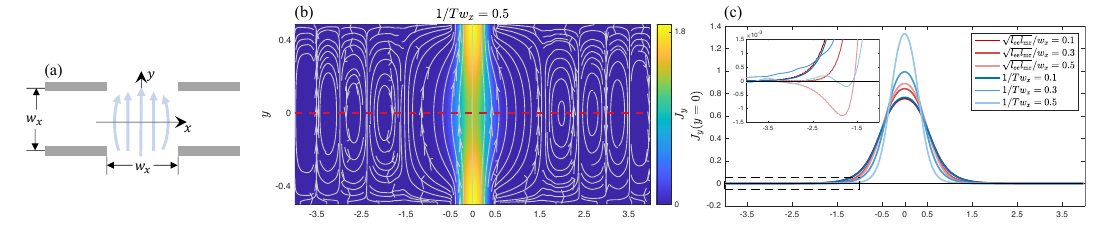
Figure 13: Vortices in a strip geometry. (a): the constriction (gray area) is located / 2 and | x | ≥ w / 2 with w = 1 µ m and w (cid:28) w at y = ± w . The current en- x x x y x / 2 and exists through a slit at y = w / 2. (b): 2D ters through a slit at y = − w x x = 0.5. The number of vortices current distribution of J and streamlines for 1 / Tw y x would increase with increasing strip length. The tiny asymmetry is due to numeri- cal discretization. The horizontal dashed line indicates the line at which the current distributions in (c) are calculated. (c): current distribution of J on the line y = 0 y for the kinetic model (red) and our holographic model at zero density (blue). The (cid:112) (cid:96) = (cid:96) (cid:96) inset zooms on the backflows. By fixing (cid:96) but changing , the kinetic ee mr ee mr model shows the ohmic-to-ballistic crossover. However, our holographic model indi- cates that the current density has a (minor) increase away from the center x = 0 in the intermediate regime, and begins to oscillate around zero in the quantum critical regime corresponding to the multi-vortex structure developed in (b). Note that the magnitude of the vorticity is much weaker than in the ballistic